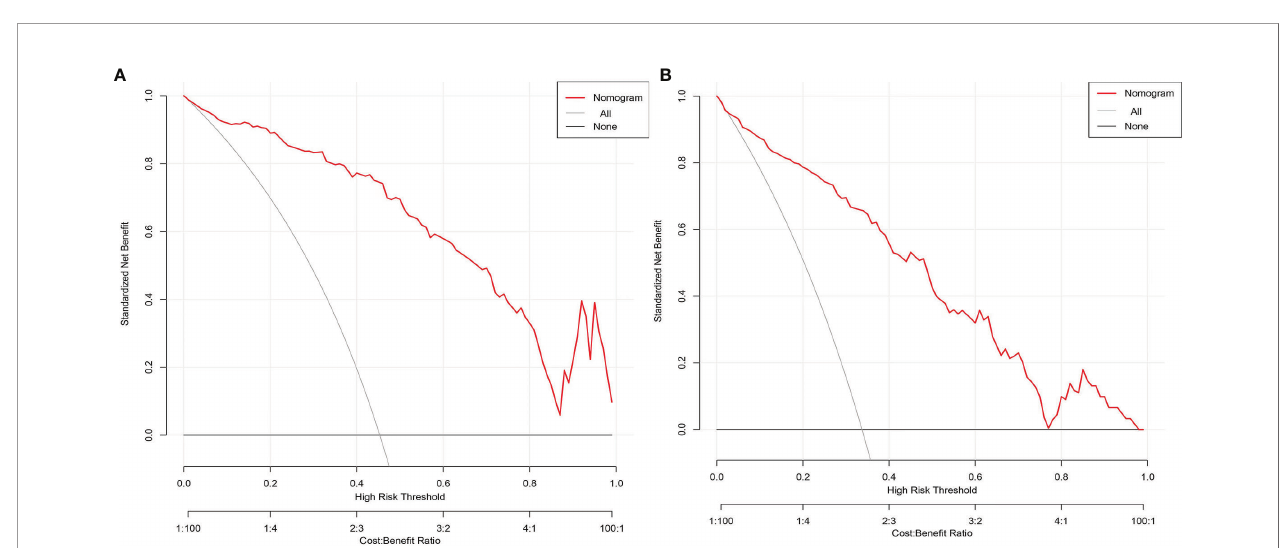
FIGURE 11 | (A) Decision curve analysis for assessing disease severity at admission. (B) Decision curve analysis for predicting short-term